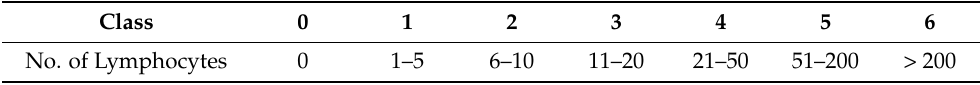
Table 2. Lymphocyte count binning in ordinal classes.